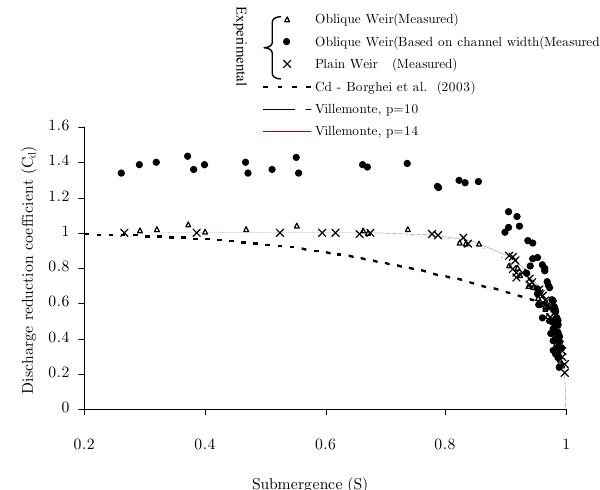
Fig. 12. Discharge reduction coefficient ( C d ) versus submergence, S (angle of obliqueness is 45 ◦